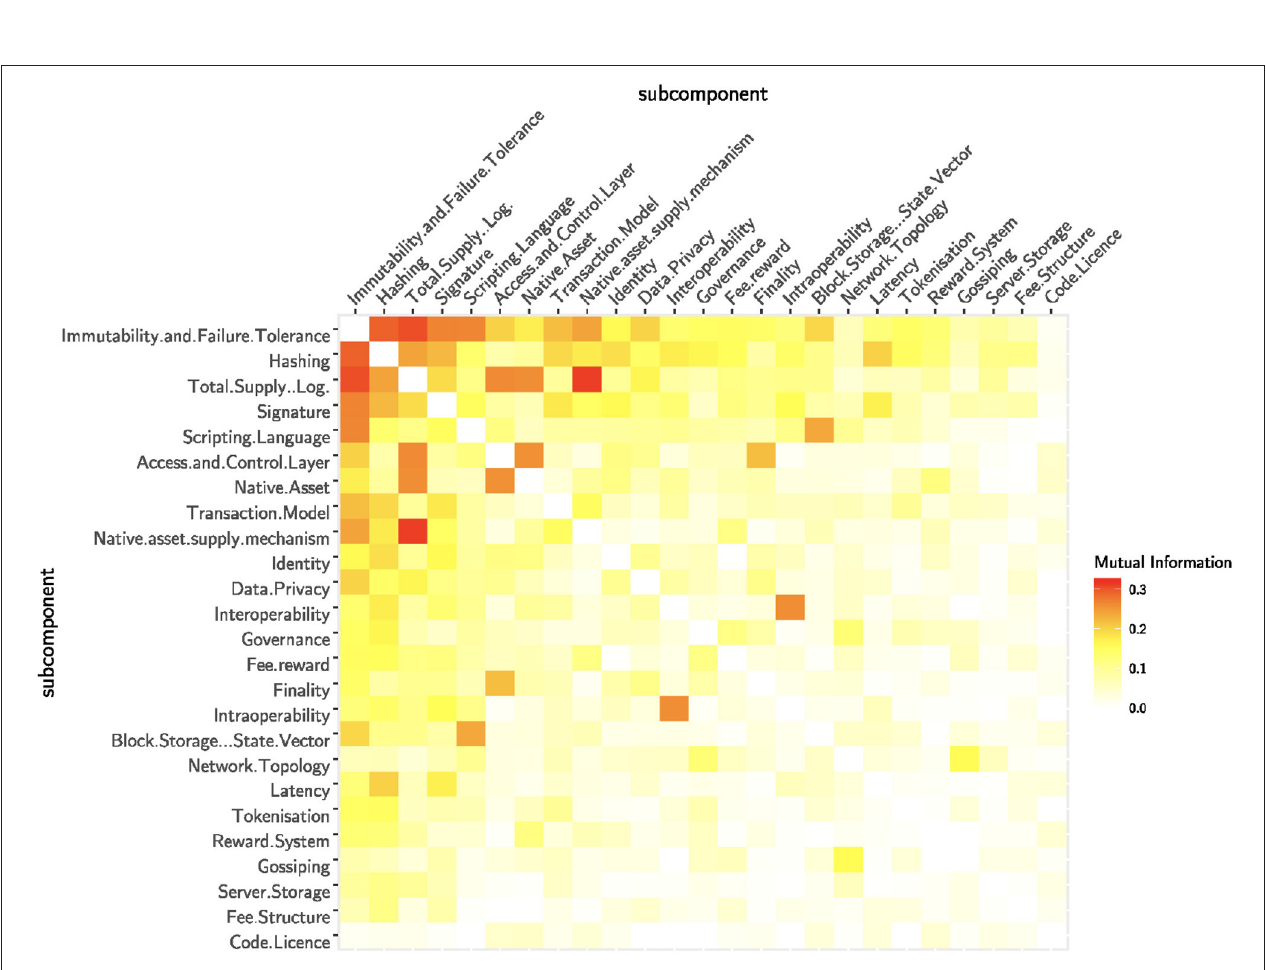
FIGURE 5 | The normalized mutual information measures the dependencies between the sub-components. The sub-components are ordered by the total amount of mutual information.